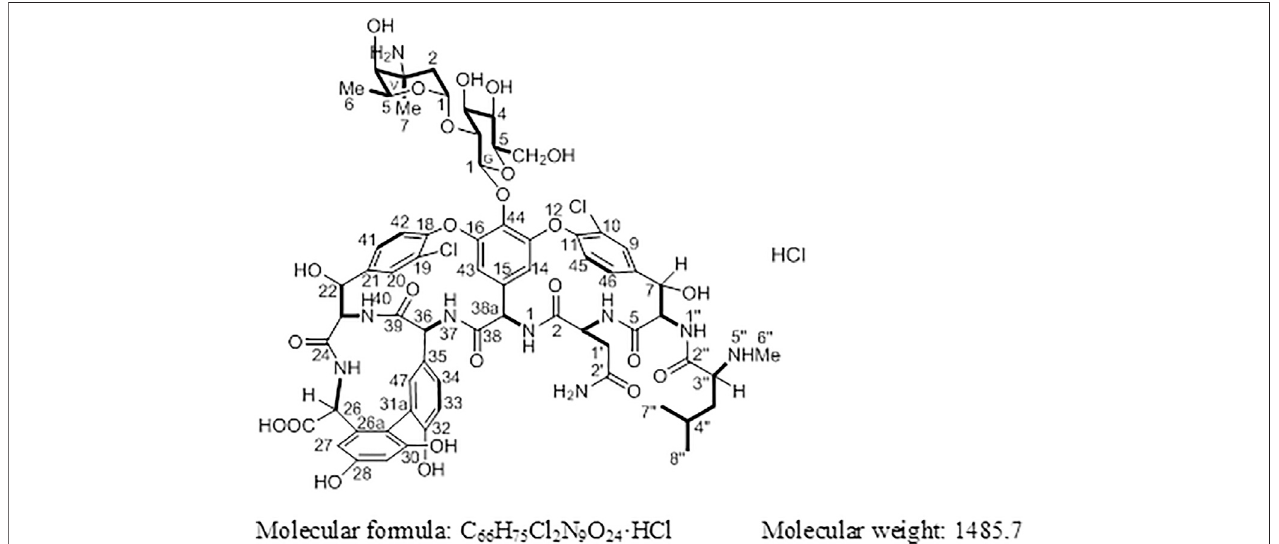
FIGURE 1 | Structure of vancomycin hydrochloride